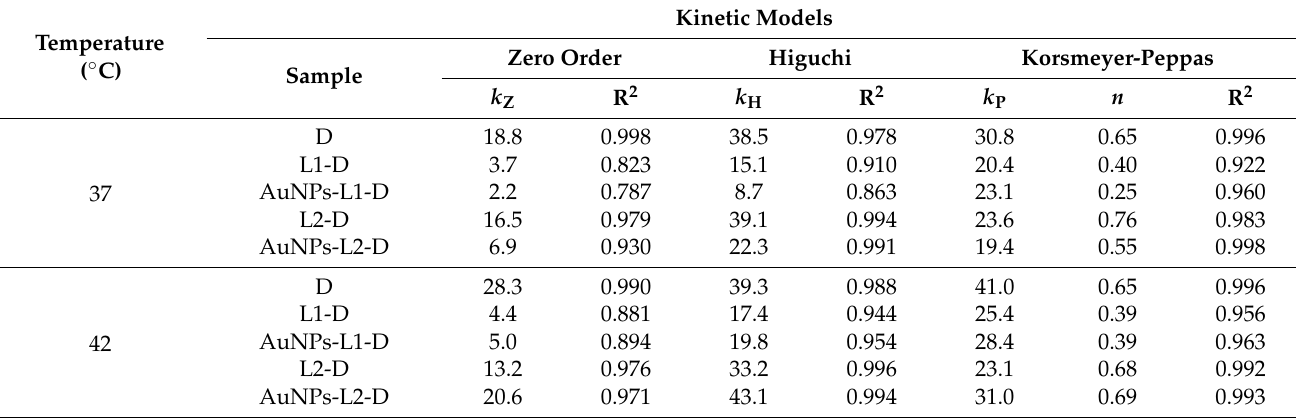
Table 3. Kinetic data obtained from doxorubicin (D) release studies toward Hepes buffer pH 7.4 at two different temperatures, using Zero order, Higuchi and Korsmeyer-Peppas